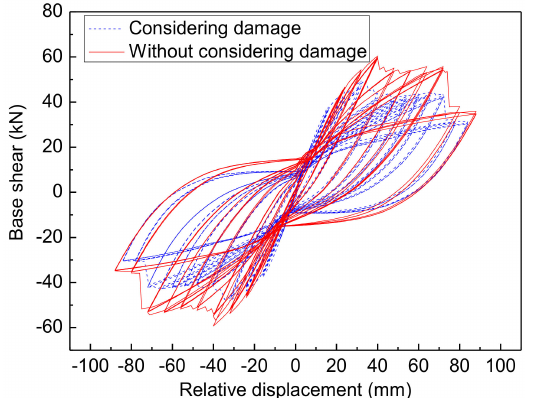
Figure 14. Comparison of results between considering damage and without considering damage for the repaired Column